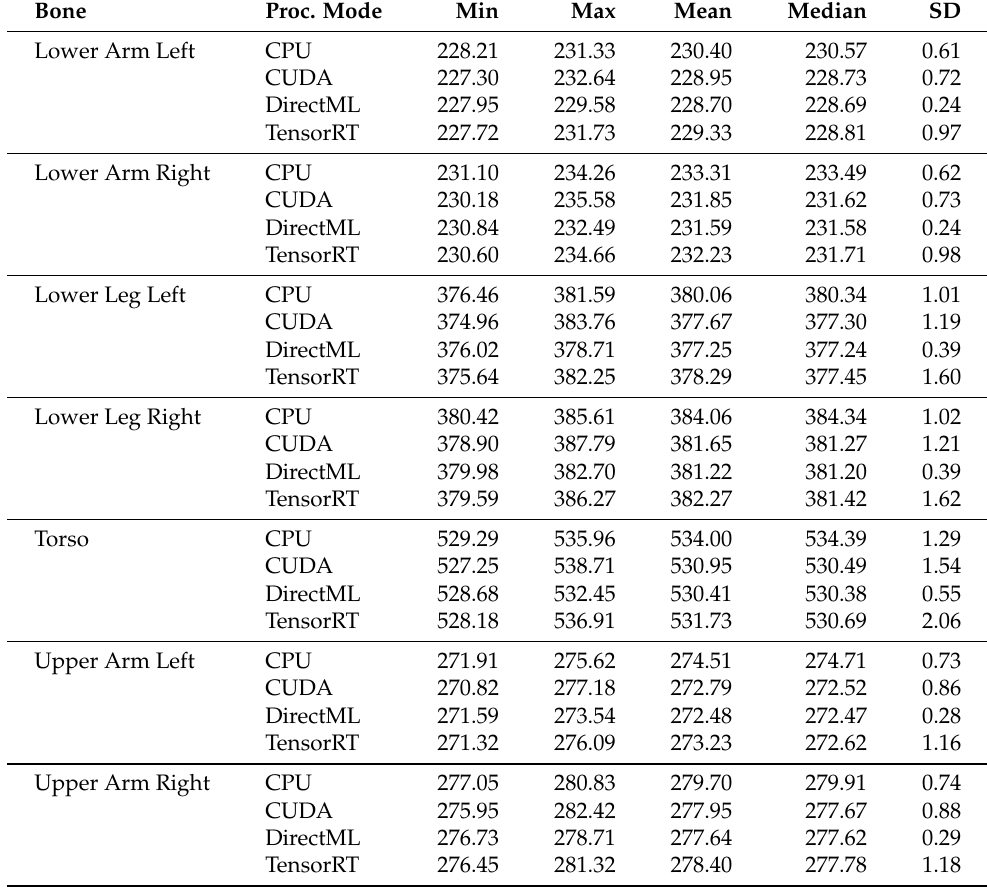
Table A4. Bone lengths for each joint and processing mode. All values are in